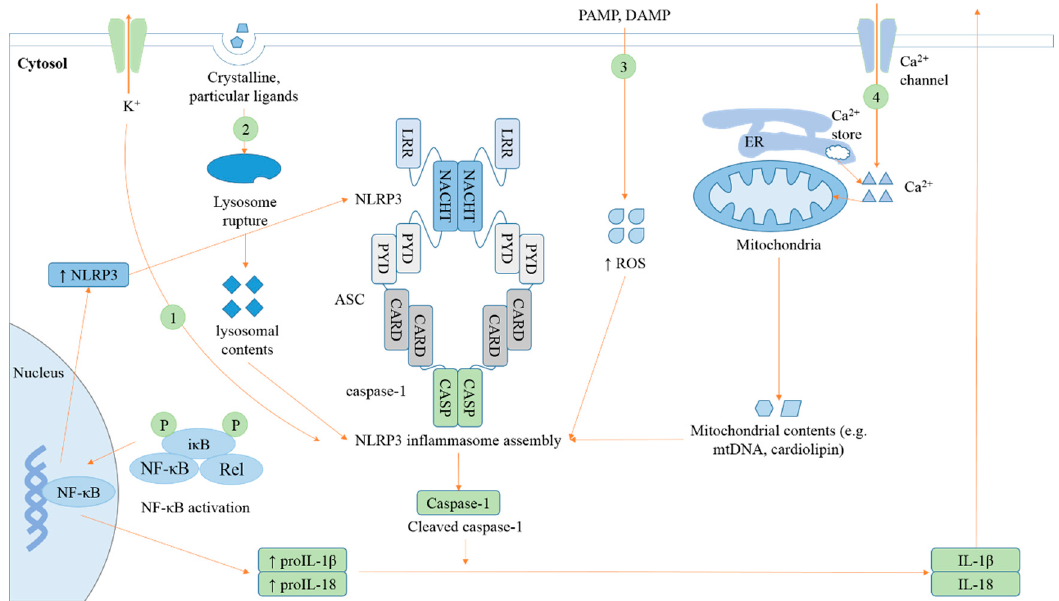
Figure 1. Models for nucleotide-binding domain, leucine-rich-repeat-containing family, pyrin domain-containing 3 (NLRP3) inflammasome activation. Four models for NLRP3 inflammasome activation that may not be exclusive have been proposed: (1) Multiple signal transduction pathways triggered by pathogen-associated molecular patterns (PAMPs)(/danger-associated molecular patterns DAMPs) converge on K + efflux [20–22], leading to NLRP3–NEK (NIMA related kinase) interaction and NLRP3 inflammasome activation [23,24]. (2) Engulfment of crystalline or particular ligands, including monosodium urate (MSU) [25], silica [26], and amyloid- β [27], leads to lysosomal damage and resultant cytosolic release of lysosomal contents, which activates the NLRP3 inflammasome. (3) NLRP3 agonists, including ATP [28], MSU, and asbestos [29] trigger production of reactive oxygen species (ROS). This common pathway engages the NLRP3 inflammasome. However, later studies demonstrated that ROS only control NLRP3 inflammasome activation in the priming step, but not in the activation step [30]. ROS generation is even dispensable for both the priming and activation in certain circumstances [20]. (4) Ca 2+ mobilization from extracellular milieu or endoplasmic reticulum